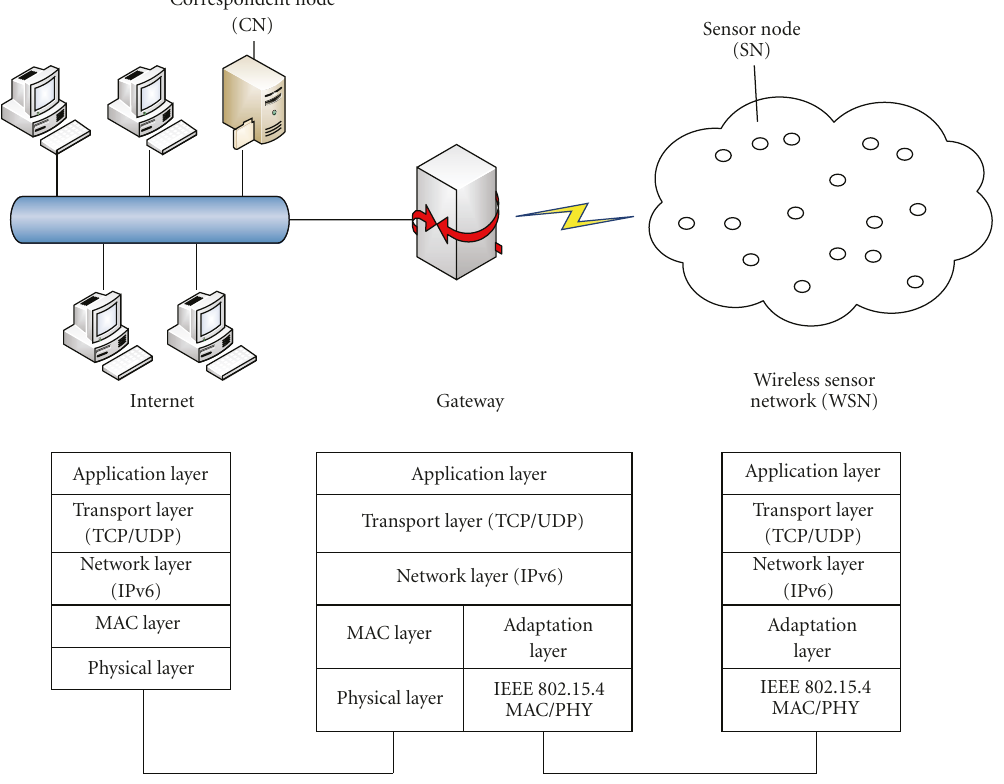
Figure 1: 6LoWPAN single-gateway network model and protocol stack.